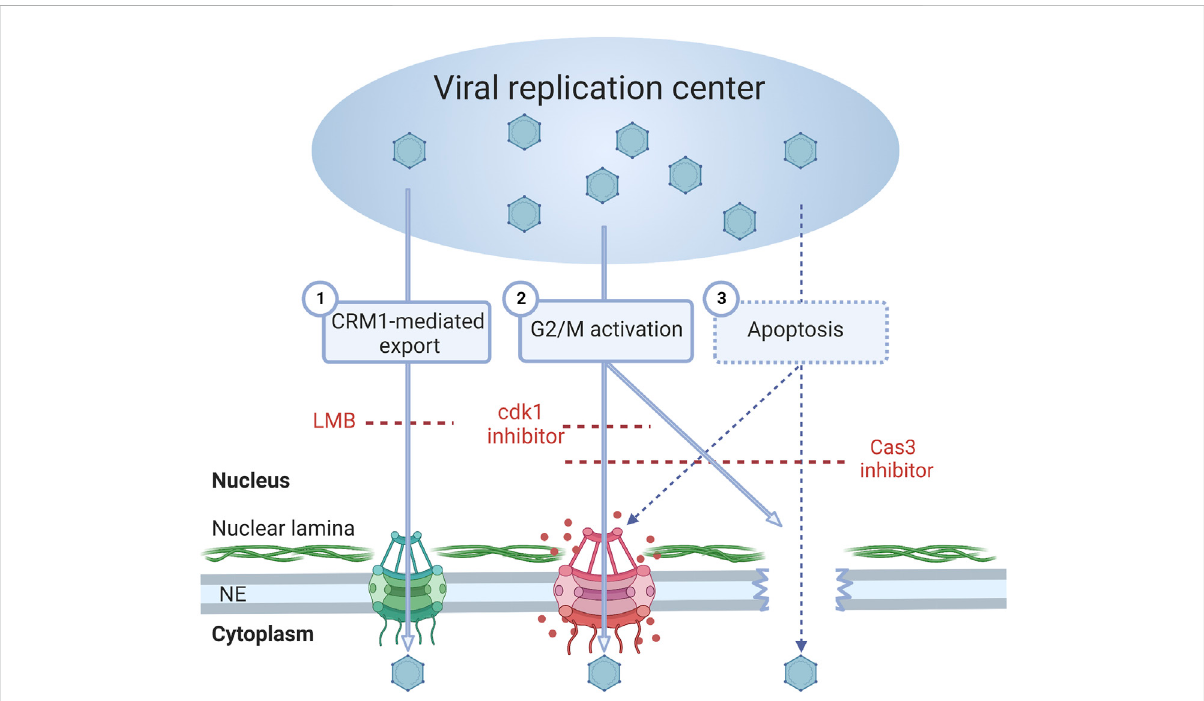
FIGURE 10 Alternative modes of nuclear exit of parvoviruses. Parvovirus capsids are assembled and matured in the nucleus of the host cells. During the progression ofinfection,thevirus-induceddamage response isfollowed bythepre-mitotic cell cyclearrest.(1)Earlier studies have shown that MVM capsids are released from the nucleus to the cytoplasm via an export factor CRM1-mediated nuclear transport pathway through nuclear pore complexes. CRM1 - dependent nuclear export is inhibited by leptomycin B (LMB). Our studies suggest that two additional nuclear exit pathways may play a role in capsid egress. (2) First, we showed that infection induces activation G2/M checkpoint. Upon activation of mitosis, the nuclear lamina undergoes disintegration, which is followed by nuclear envelope breakage, thereby allowing passive diffusion of capsids through the nuclear envelope. Inhibition of cyclin-dependent kinase 1 (cdk1) blocks the nuclear envelope leakage. (3) Second, infection induces caspase-dependent apoptosisininfectedcells.Duringtheearlystagesoftheapoptosis,thecapsidegressisfacilitatedbyanincreaseintheenvelopepermeabilitycaused by the disintegration of the nuclear lamina, together with the disassembly and enlargement of NPCs. Caspase 3 also has a potential role in the regulation of mitosis. The apoptosis-induced nuclear envelope leakiness can be prevented by exposure to a Caspase 3 (Cas3)